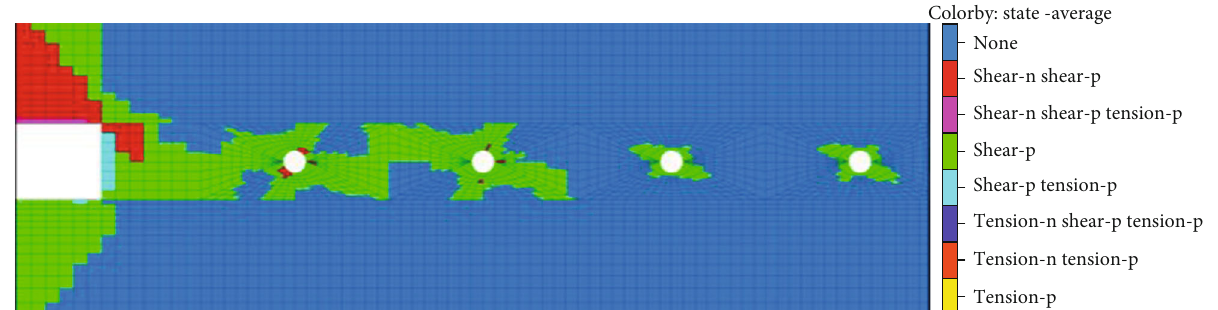
Figure 14: Distribution of plastic zone of boreholes along the incline of the working